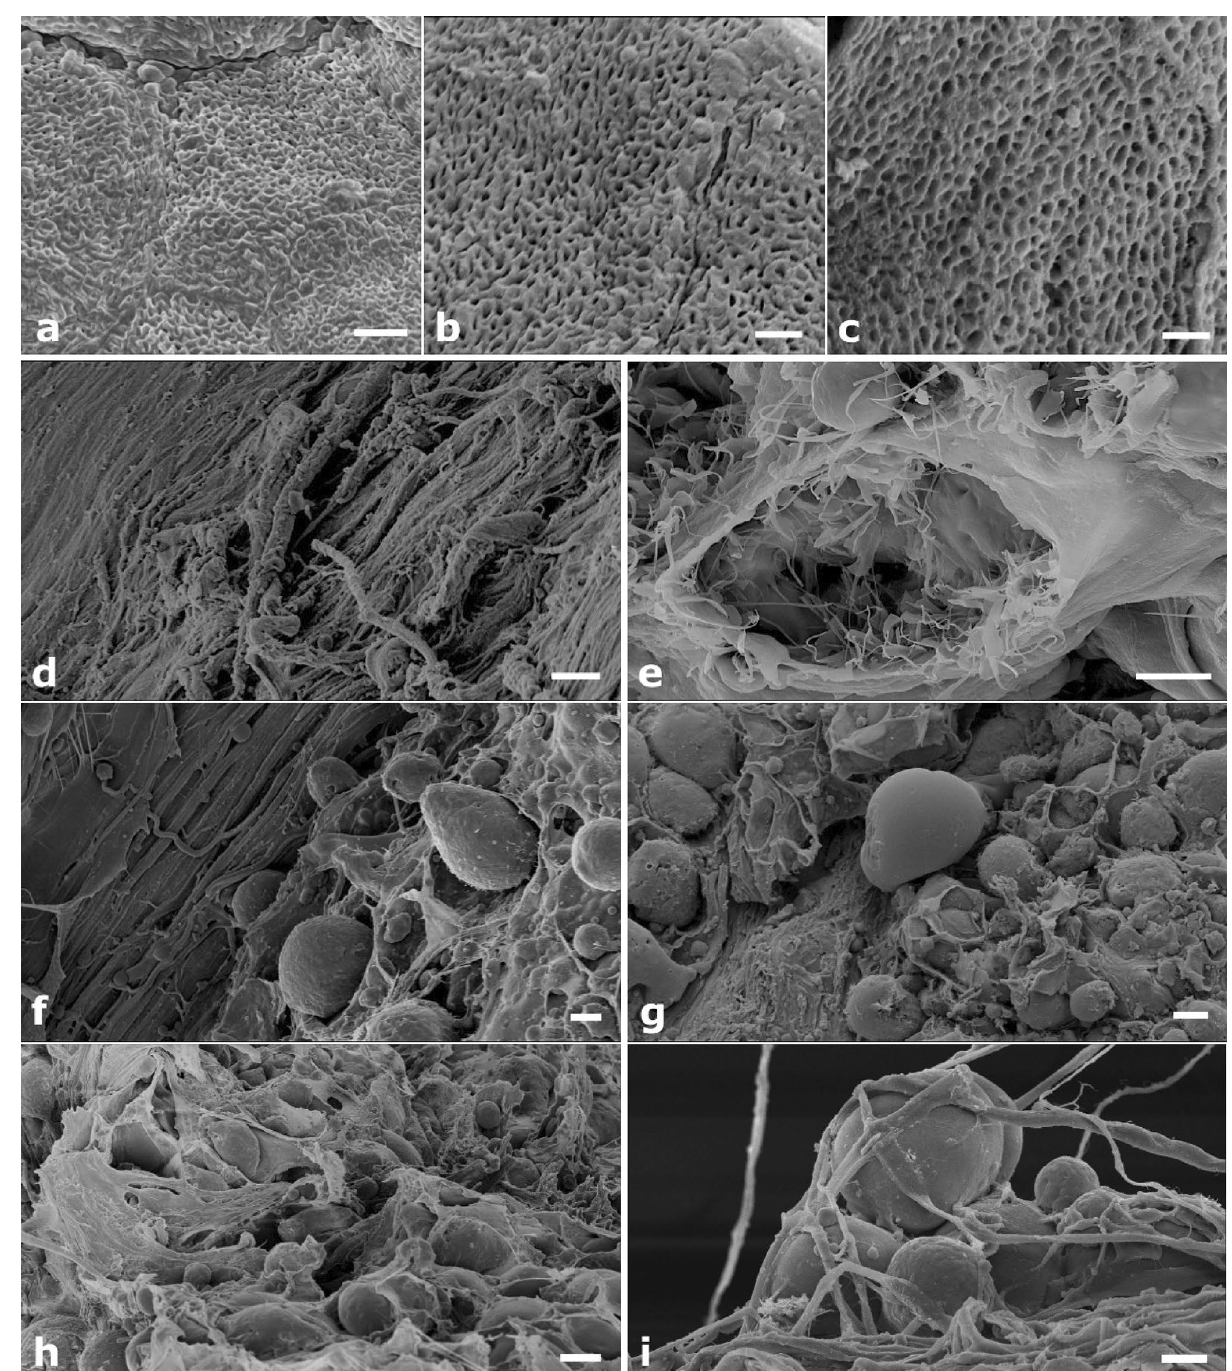
Figure 6. ( a – i ) SEM images of the bone scaffold. ( a – c ) The tissue texture is unaltered in the natural untreated bone sample ( a ), it appears well preserved in the decellularized sample ( b ) and shows no apparent modification or damage after microporation ( c ). ( d , e ) More in detail, the decellularized and micro-pored scaffold reveals a cell-free collagen matrix ( d ) and well preserved cellular niches ( e ). ( f , g ) 7 days after seeding, MSCs have colonized the decellularized and pored structure, with cells randomly dispersed and well anchored to micropores ( f ), however they remain superficially ( g ). ( h , i ) 14 days after seeding, the scaffold is covered with cells ( h ) that grow inwardly in a multilayered disposition ( i ). Bars: ( a )—2 μm; ( b )—1 μm; ( c )—1 μm; ( d )— 20 μm; ( e )—5 μm; ( f )—10 μm; ( g )—20 μm; ( h )—20 μm; ( i )—10